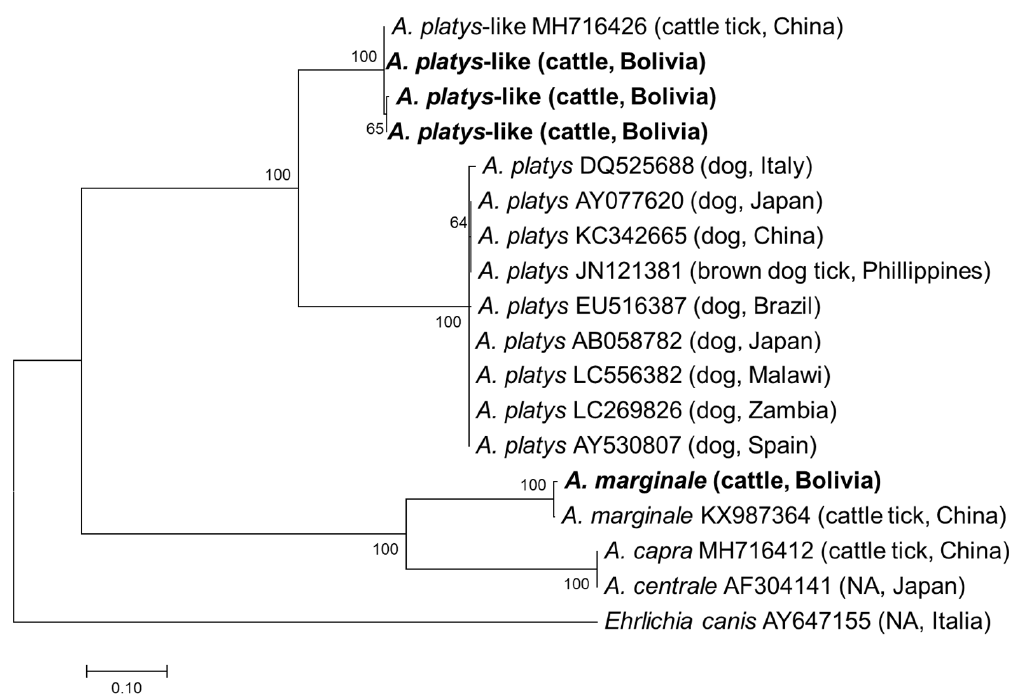
Figure 3. Phylogenetic tree based on gltA sequences in Anaplasma species. The phylogenetic tree was constructed using MEGA7 based on the maximum likelihood method using the Kimura 2-parameter model. Only bootstrap values greater than 60% are indicated. The sequences obtained in this study are shown in bold. The host animal and geographic origin (country) of the sequence/strain are provided in parentheses. NA stands for not